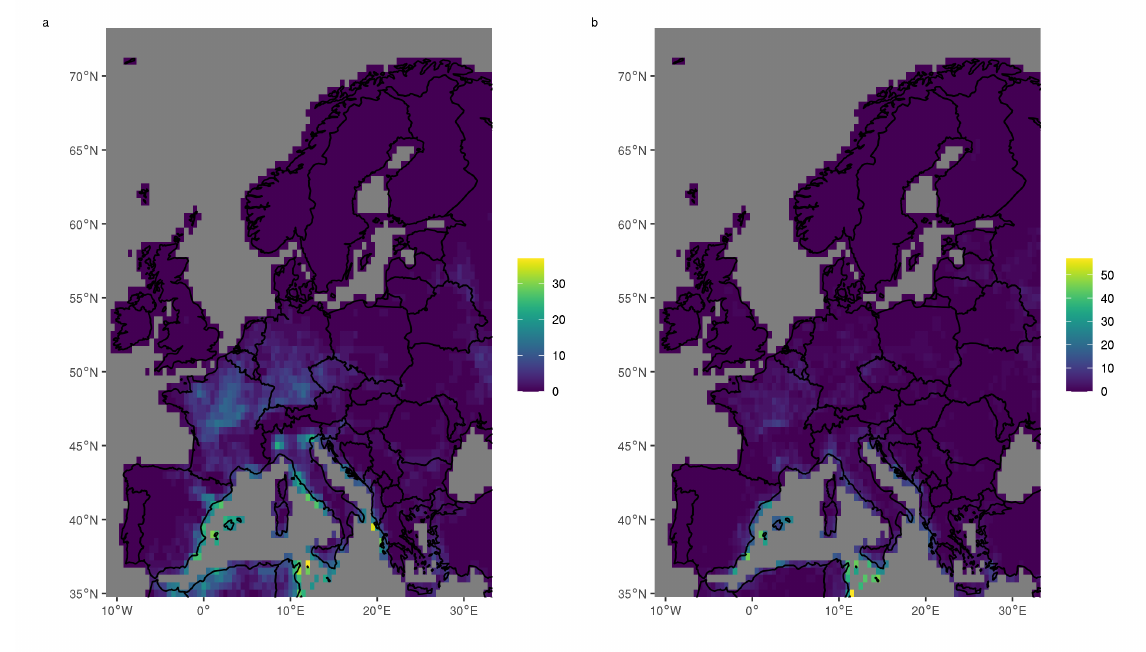
Figure 4. Count of climate forecast system (CFS) reanalysis days between 1979 and 2015 with ( a ) Craven parameter greater than 30,000 m 3 s − 3 and ( b ) significant tornado parameter greater than